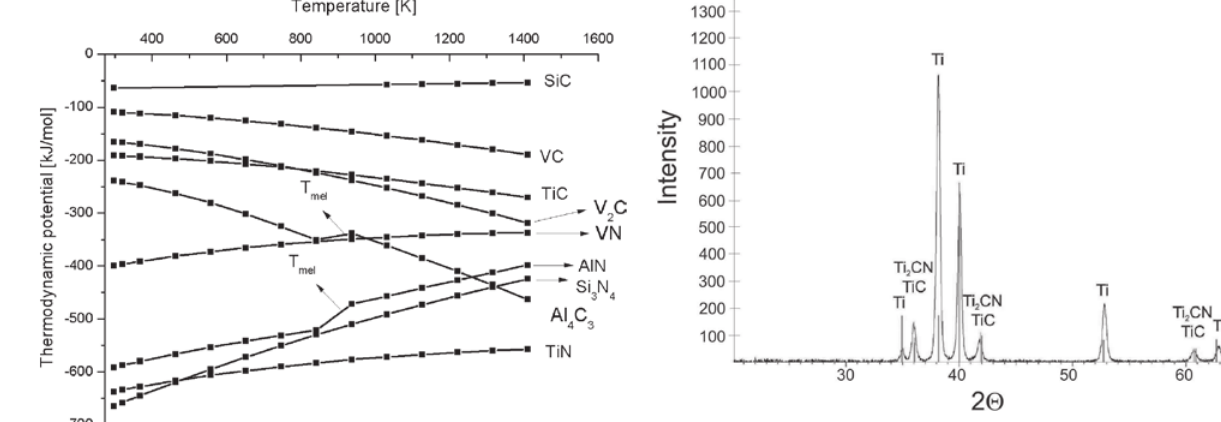
Fig. 5: XRD analysis of alloy sample with SiC x N y (H)